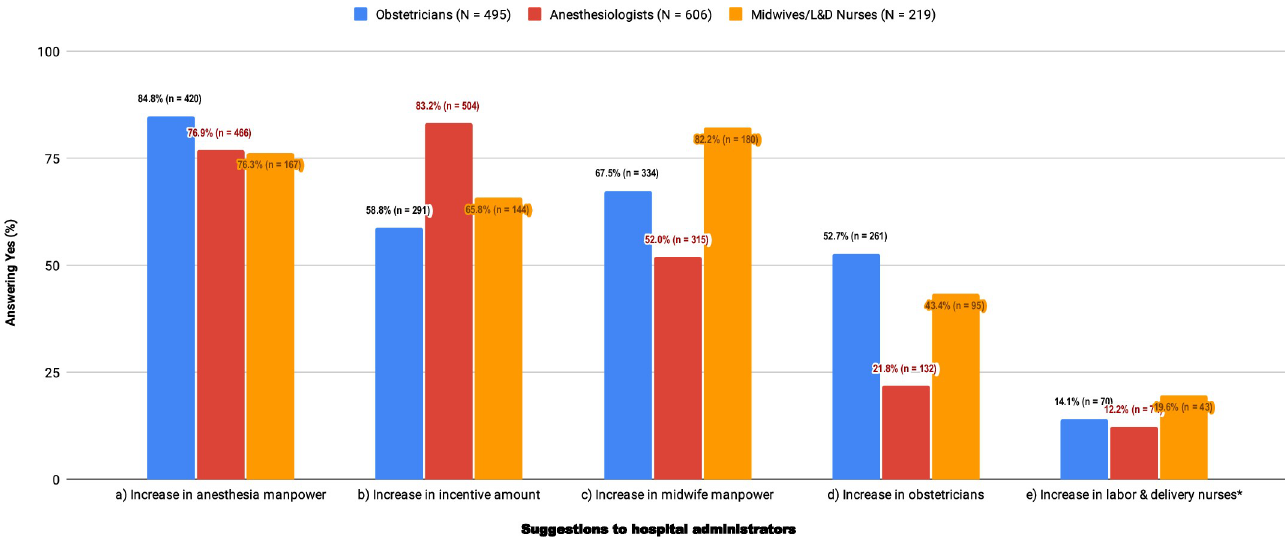
Fig 3. Q3: What to suggest hospital administrators to promote labor epidural analgesia service presuming they are willing to support? ( � one choice). Q3: question 3, N: numbers of the individual study group, n: numbers of the respondents; � : no statistically significant difference at the level of p -value = 0.01.